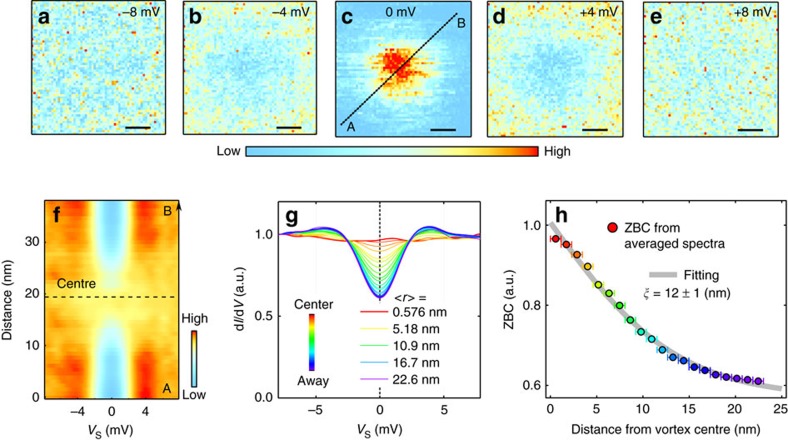
Spectral evolution around a vortex core.A single vortex core is investigated at the temperature of 4.2 K with applying a magnetic field of 1.5 T normal to the surface. (a–e) Conductance mappings around an isolated single vortex core with various sample-bias voltages. A STM tip is stabilized at a tunnelling current of 30 pA and a sample-bias voltage of −10 mV. The energy window of numerical derivative to obtain conductance spectrum is 1 mV. Scale bars, 6 nm (a–e). (f) Spatial evolution of tunnelling spectra across the vortex centre (the line is shown in c). (g) Averaged spectra as a function of distance from vortex centre <r>. (h) Zero-bias conductance (ZBC) obtained from g. Coherence length of ∼12 nm is obtained by fitting the ZBC (see main text for details). A total 3,600 spectra (60 × 60) were taken with equal spacing in the region (a–e). We classified the area of Fig. 4a–e into 20 regions based on the distance from vortex centre (see also Supplementary Fig. 3). Interval of <r>, which is 5.758 nm, is set as error bars for x axis in h.